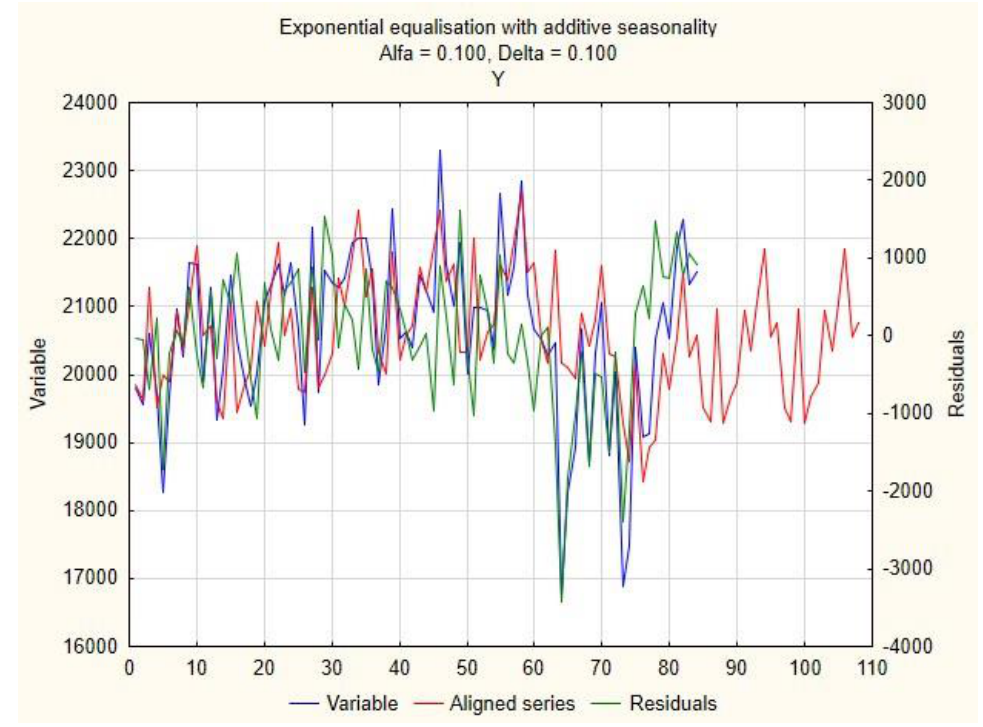
sults obtained with the use of Statistica 13.3 software are shown in Figure 6.